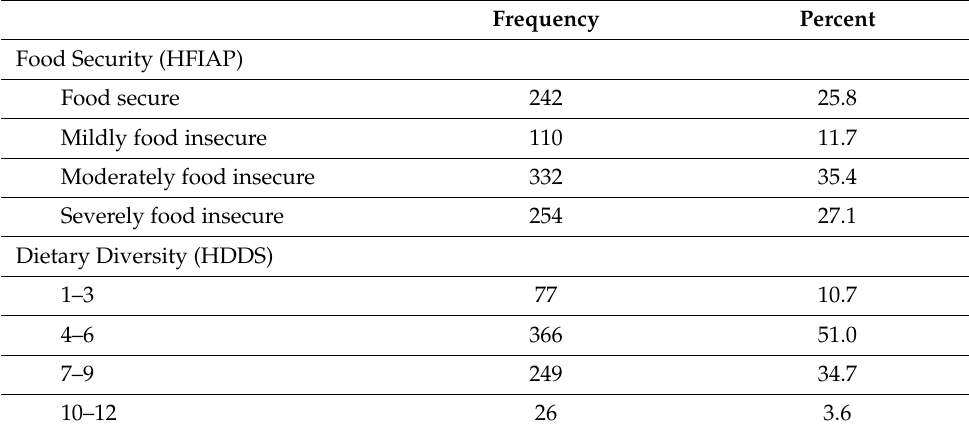
Table 5. Migrant household food security and dietary diversity.